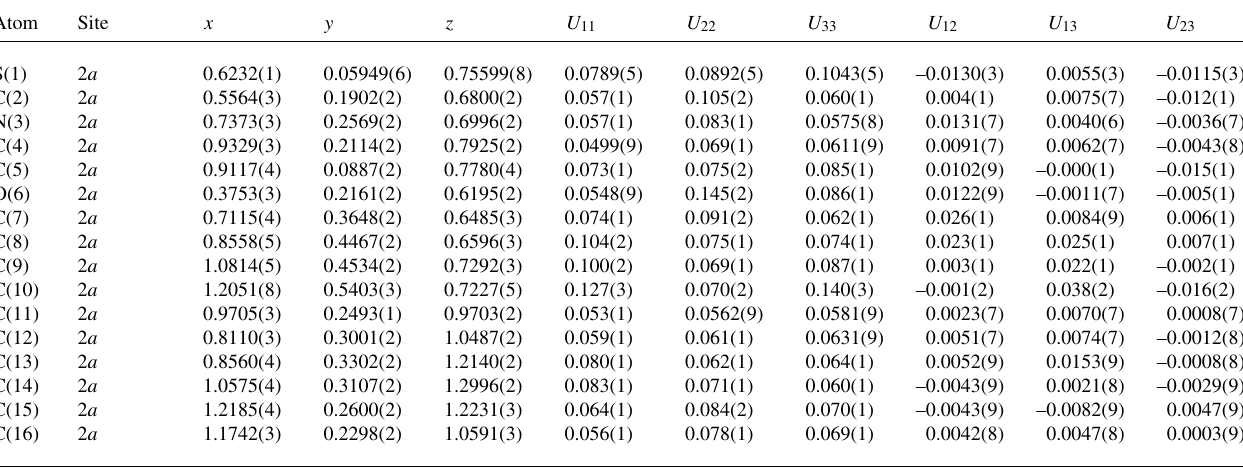
Table 3. Atomic coordinates and displacement parameters (in Å 2 ) .